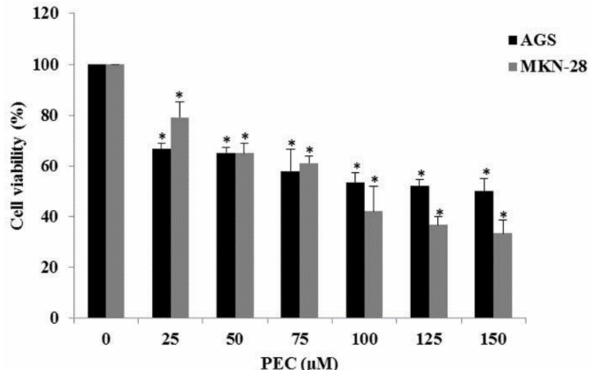
Figure 1. Pectolinarigenin (PEC) reduced cell viability of human gastric cancer cells. AGS and MKN28 human gastric cancer cells were incubated with concentration ranging from 0 to 150 µ M of PEC for 24 h. Results are expressed as the mean ± standard deviation (SD) of at least three independent experiments. Statistical differences were analyzed with Student’s t -test (* p < 0.05 vs.